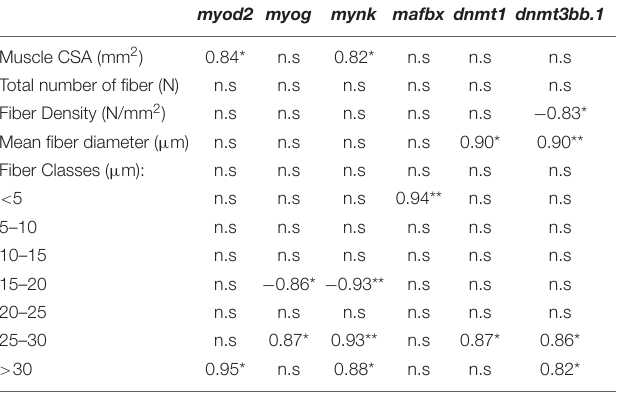
Frontiers in Physiology |